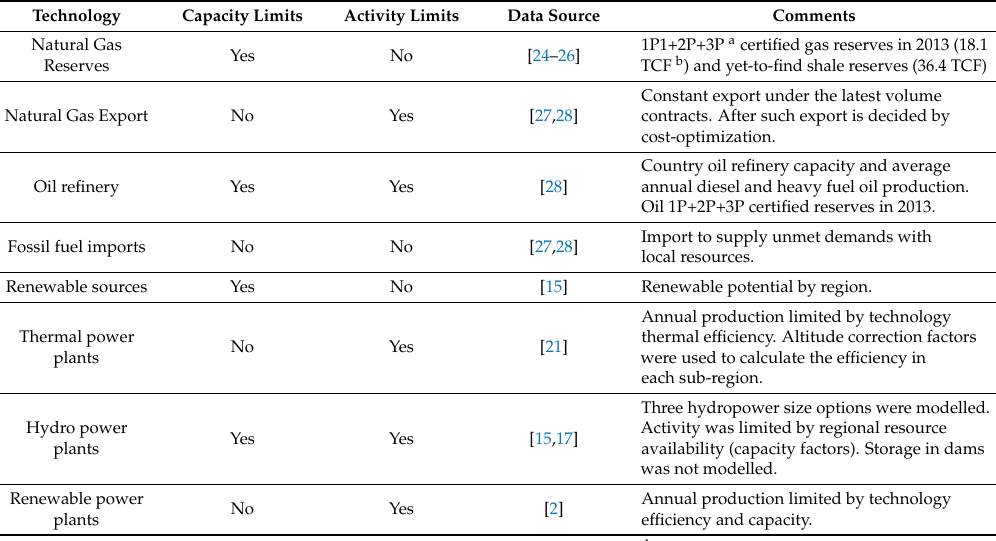
Figure 2. Energy system representation. Table 1. Summary of assumptions in technology capacity and activity boundaries.